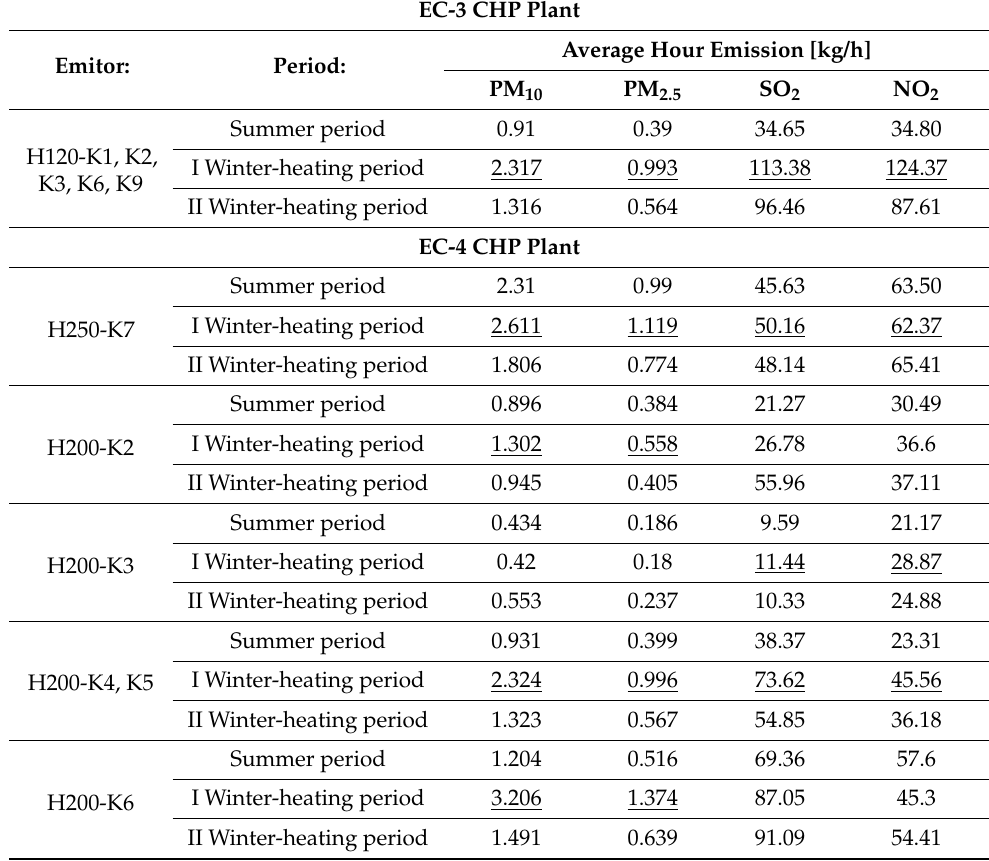
Table 4. Average hourly emissions of pollutants for the EC-3 and EC-4 CHP plants, divided into sub-periods (own calculations based on data from Veolia Energia Ł ó d´z). EC-3 CHP